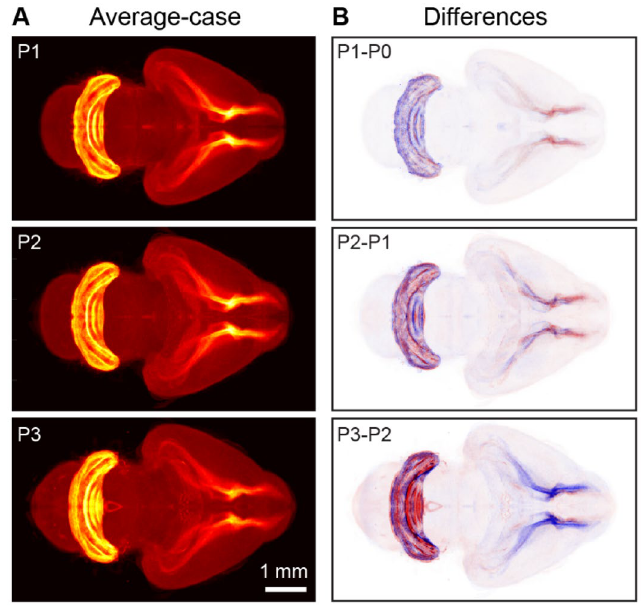
Figure 7. Example of continuous brain development dynamics detected using our algorithm. ( A ) Weighted average images for mouse developing brain on postnatal days P1-P3. ( B ) Average-case differences between P1-P3 and P0-P2 brains respectively reveal the dynamics of postnatal brain development. Over the course of these three days, the density of EdU+ cells in the cerebellum increases (blue to red) whereas it decreases in the RMS (red to blue). Differential images ( B ) highlight the development dynamics not easily noticeable in the weighted average images ( A